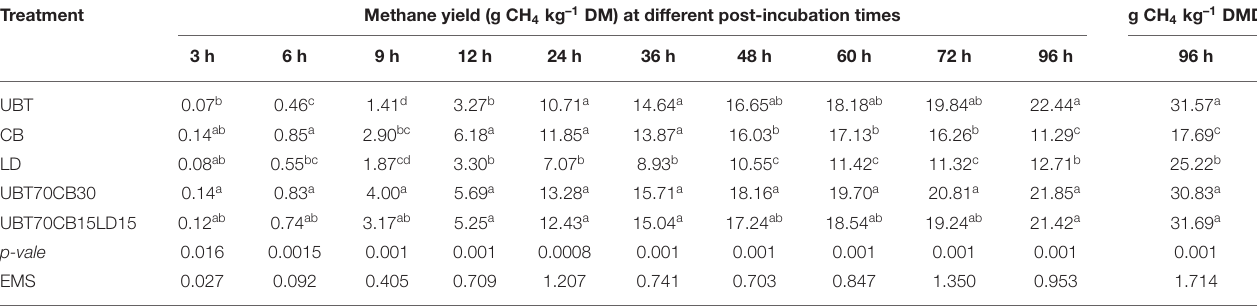
TABLE 8 | Methane yield from UBT, CB, LD, and their mixes.